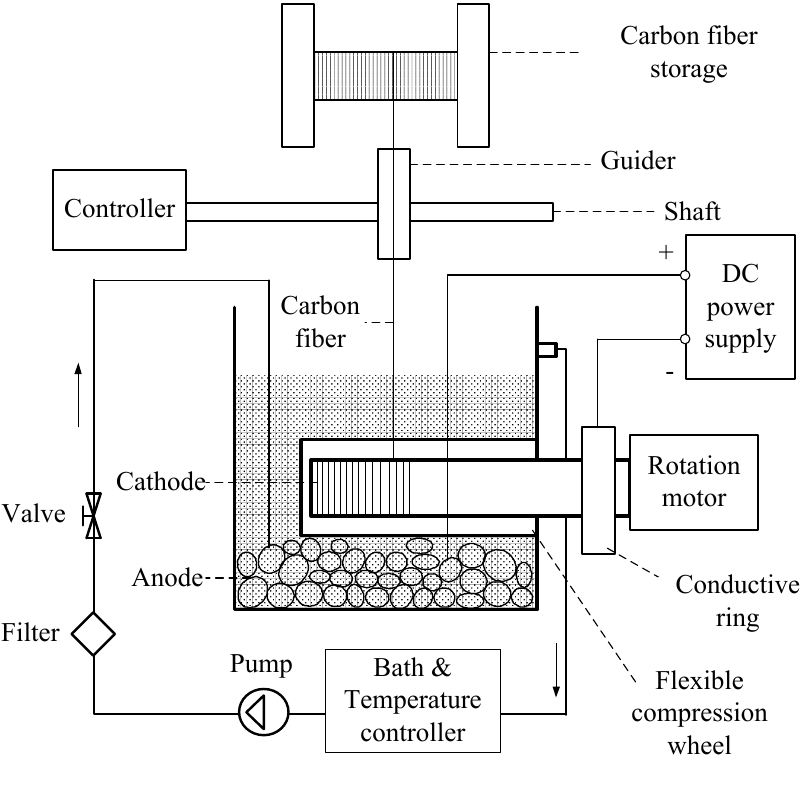
Figure 2: Schematic diagram of the experimental apparatus.